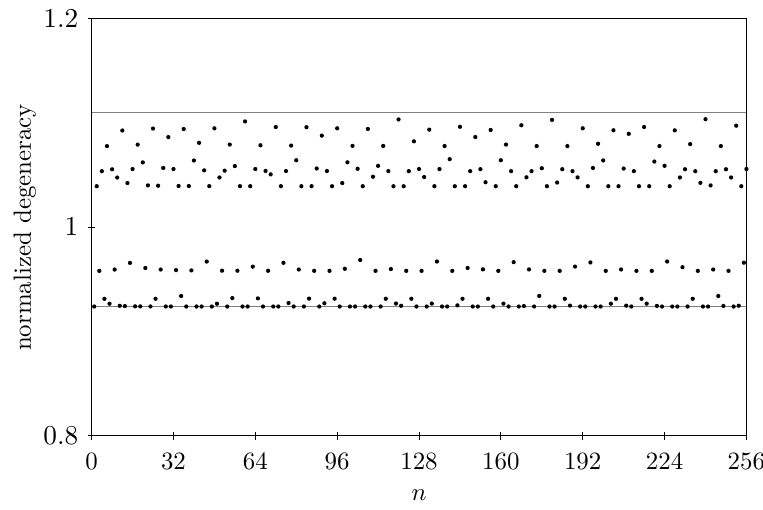
Figure 11 . The normalized degeneracies d LP fluctuate between 1 /ζ (4) = 0 . 9239 . . . and ζ (3) /ζ (4) = 1 . 1106 . . . , shown with gray lines, and they are bounded away from 1